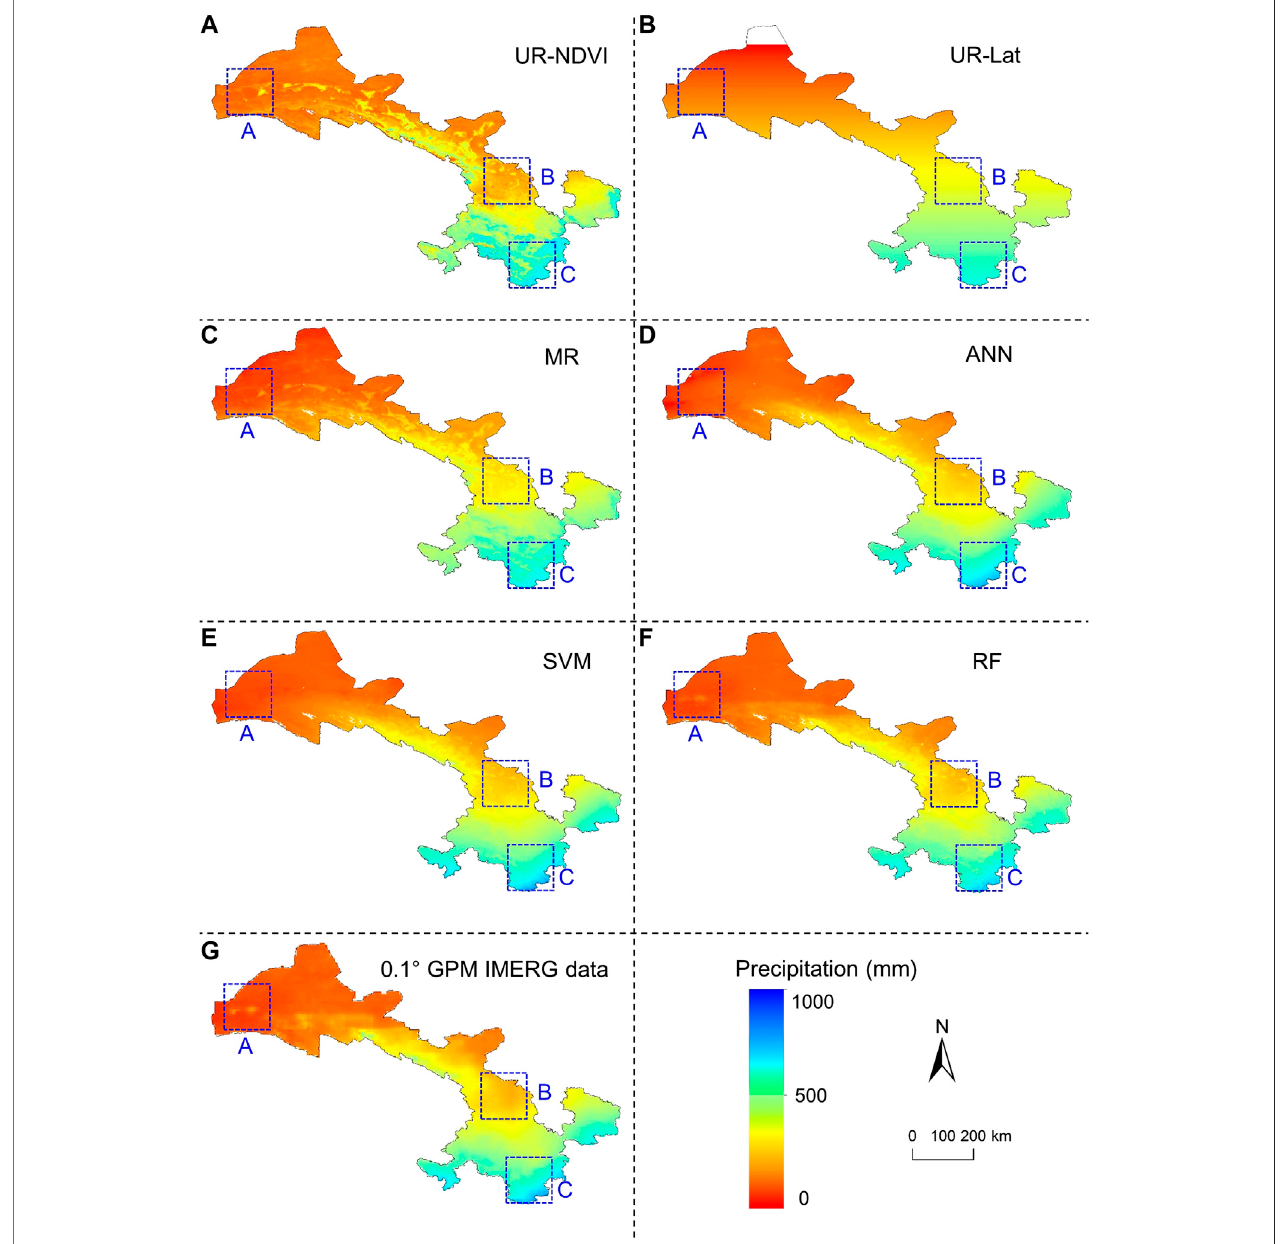
FIGURE 5 | (A – F) Downscaled 1 km IMERG precipitation without residual correction in 2015 by UR-NDVI, UR-Lat, MR, ANN, SVM, and RF; (G) original 10 km GPM IMERG data in 2015.